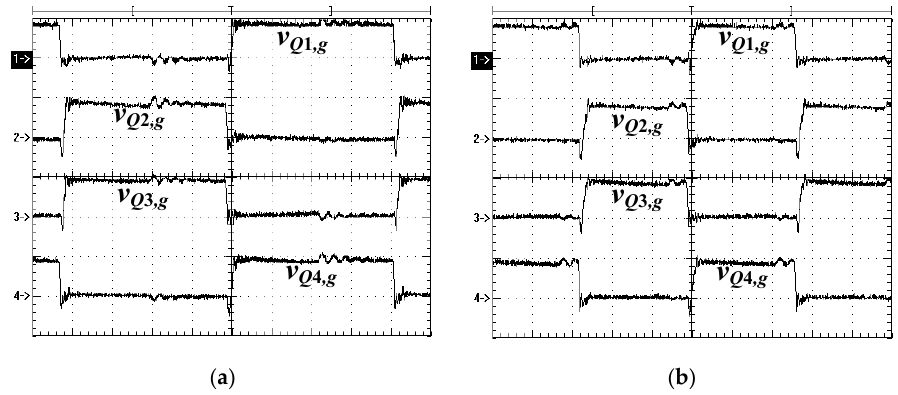
Figure 11. Measured PWM signals of Q 1 ~ Q 4 for reverse power operation and full load ( a ) V L = 36 V ( b ) V L = 52 V (v Q1,gs ~ v Q 4 ,gs : 10 V/div; time: 2 μ s).